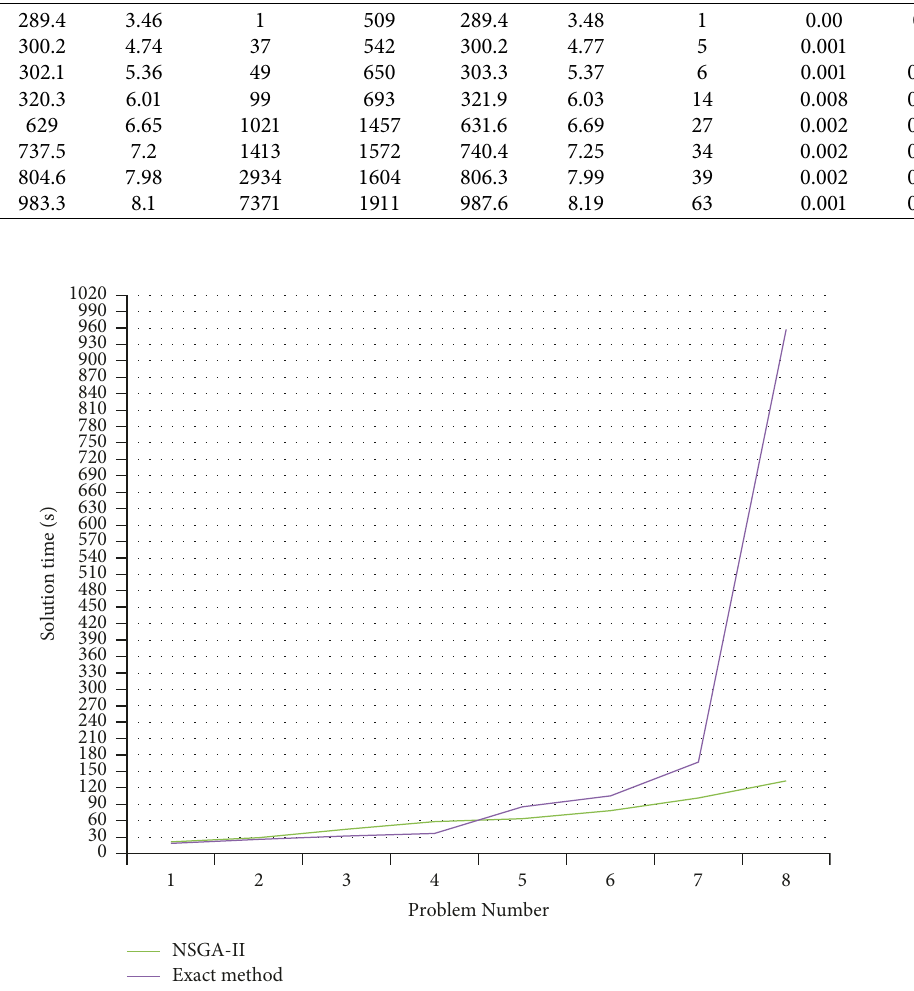
Figure 5: Solving time of numerical examples.